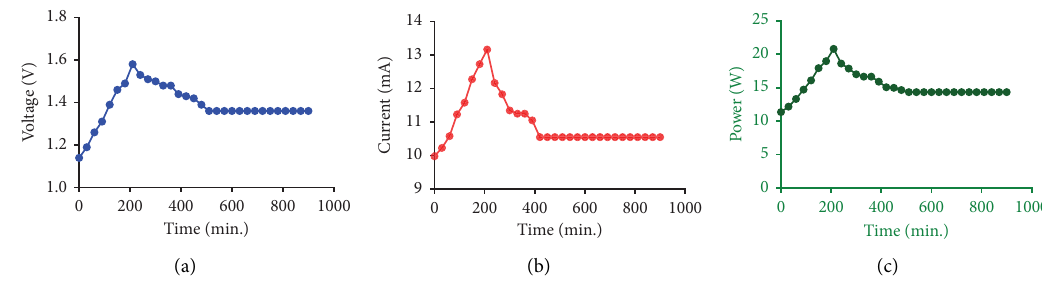
Figure 3: Time period variation of (a) voltage in V, (b) current in mA, and (c) power in W.